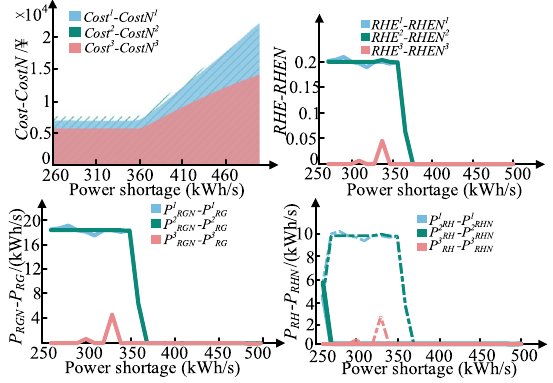
Fig. 13 Comparisons of the four differences with power shortages at L 1 −